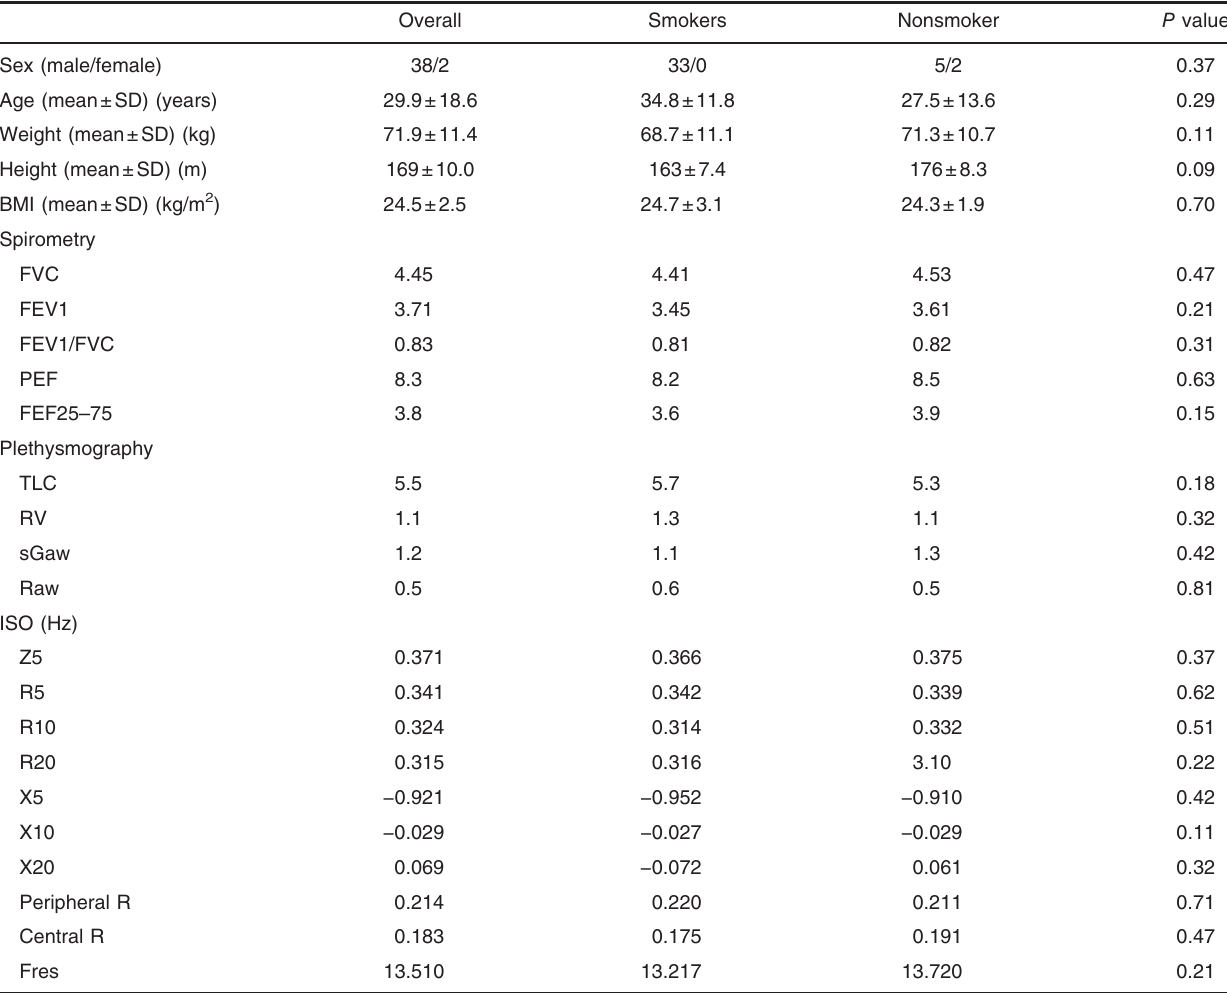
Table 1 Characteristics of participants